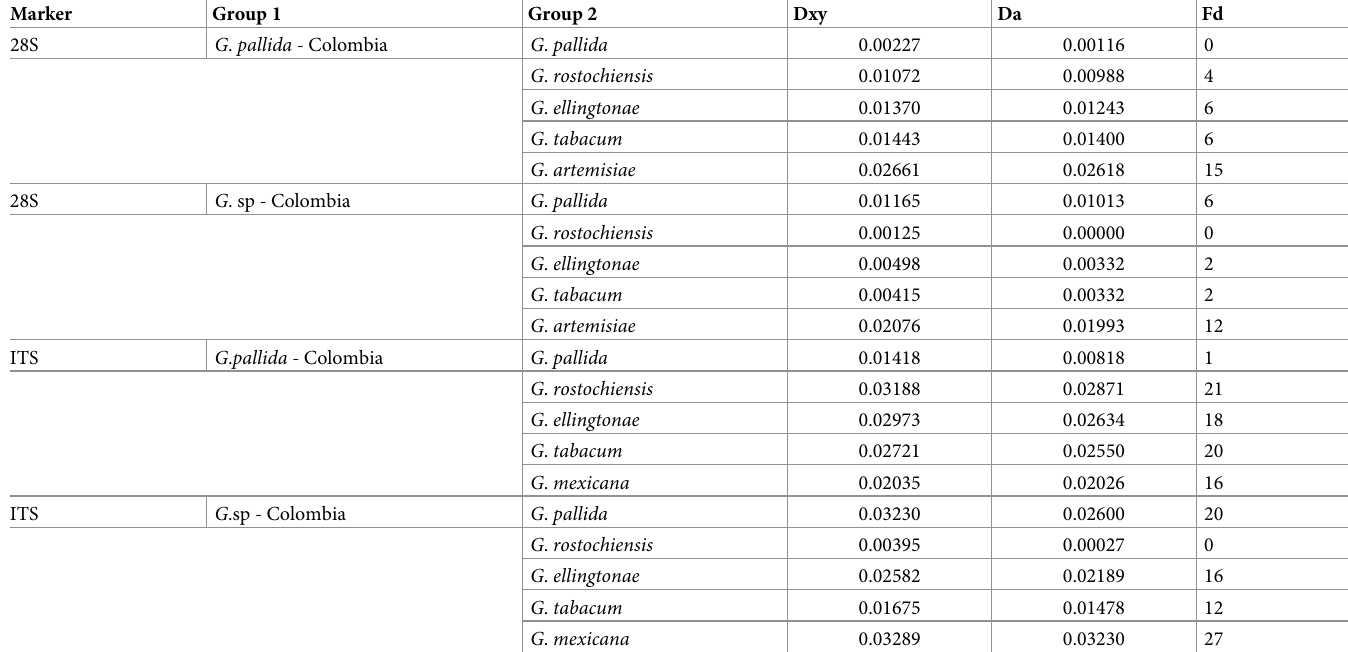
Table 4. Gene divergence between potato cyst nematodes from Colombia and other species retrieved from GenBank. Marker